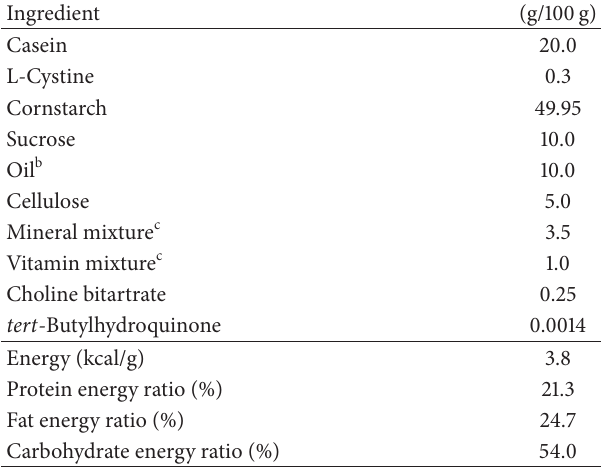
Table 1: Composition of the experimental diets a . Table 2: Fatty acid composition of soybean-oil diet (SOD) and shortening diet